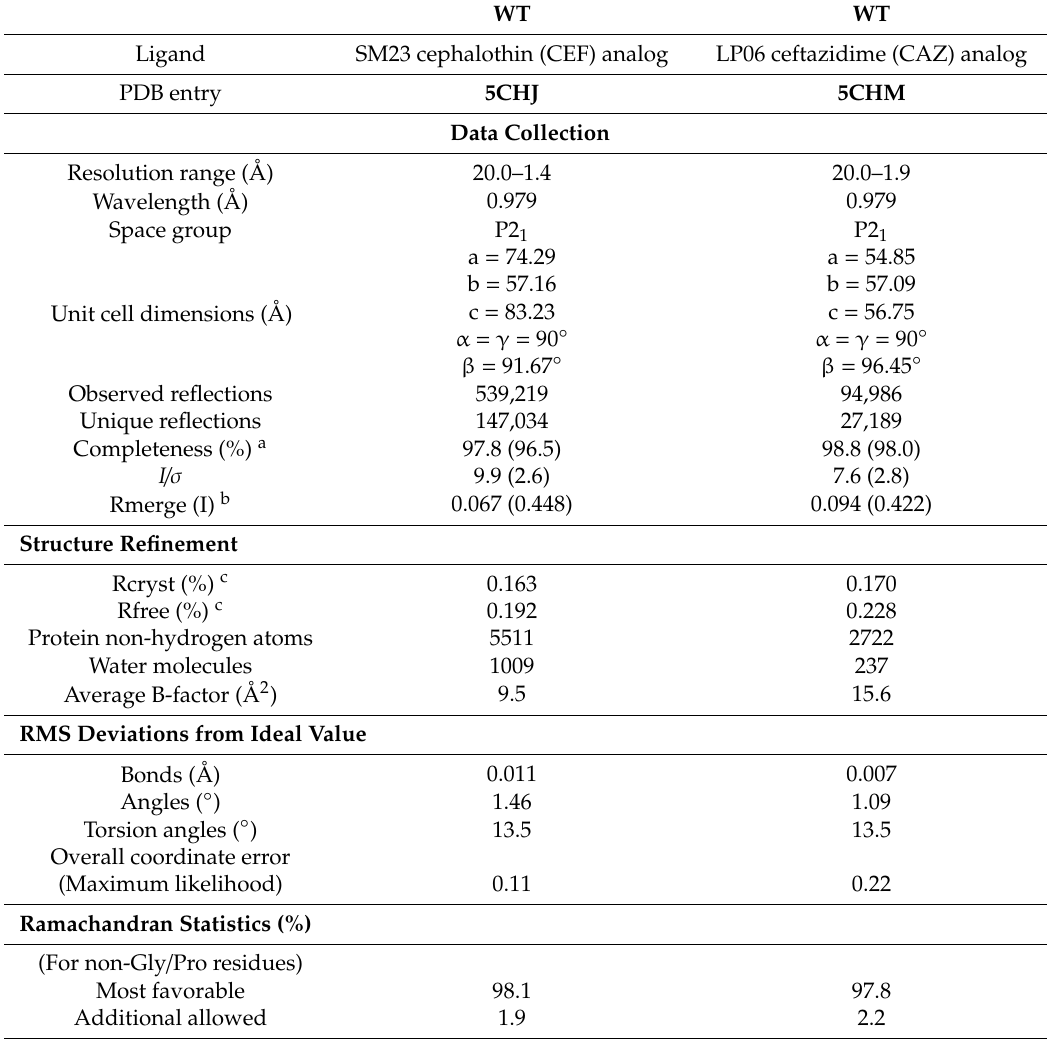
Table 1. Data collection and refinement statistics for the FOX-4 crystal